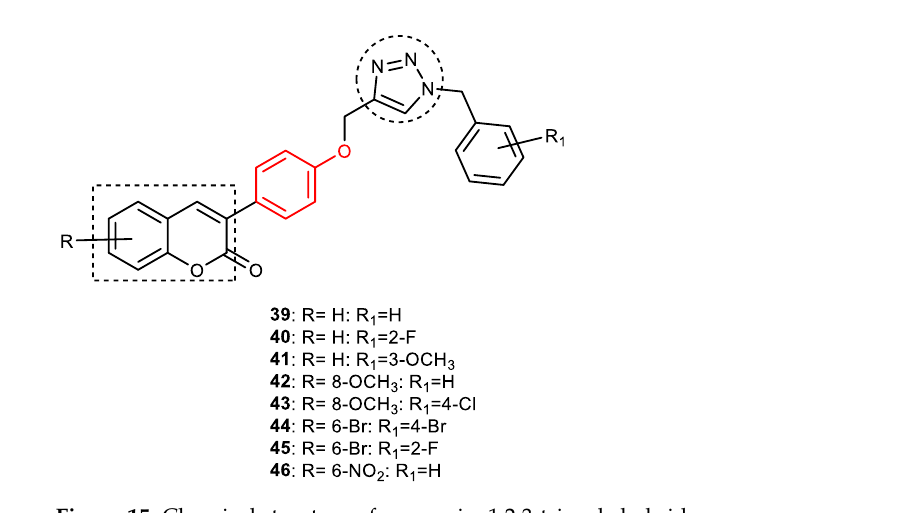
Figure 15. Chemical structure of coumarin–1,2,3-triazole hybrids.